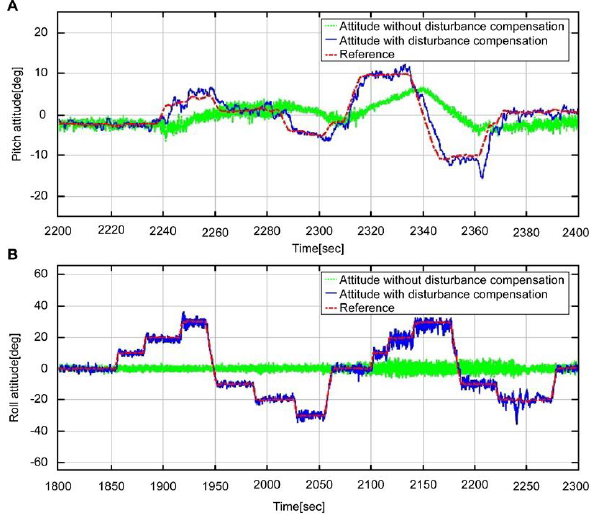
Figure 9. Attitude maneuver section by each accelerometer measurement and Reference attitude; A: Pitch attitude, B: Roll attitude.